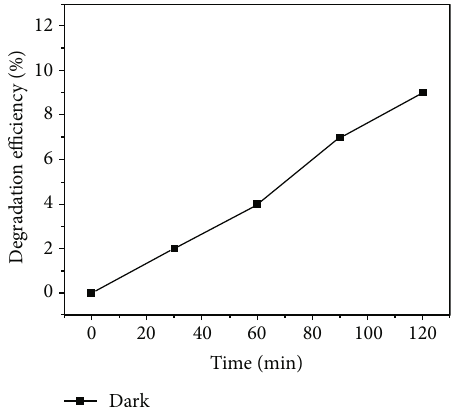
Figure 10: Photocatalysis mechanism for TiO absence of UV light illumination to degrade MB dye.